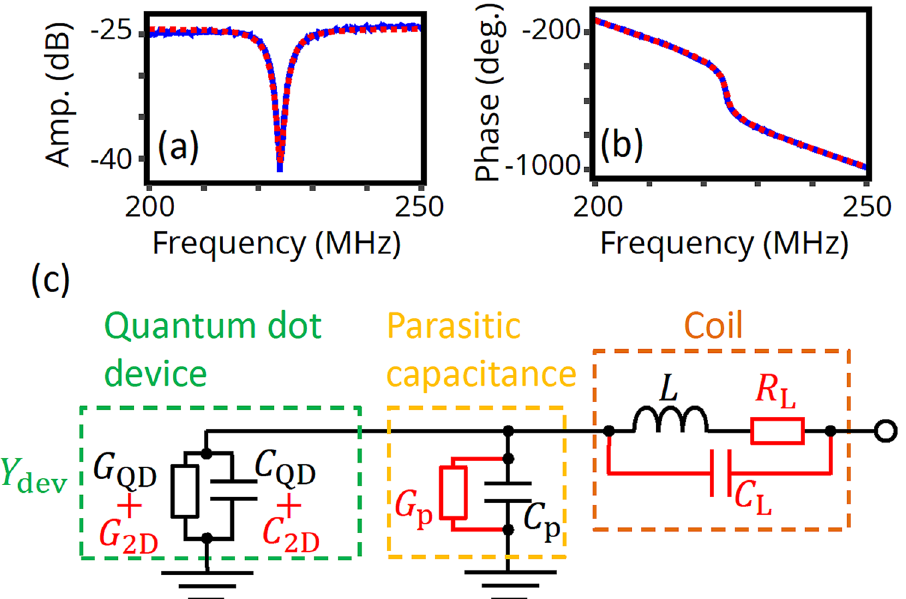
Figure 2. Frequency dependence of reflected RF signal and fitting using an equivalent circuit. ( a , b ) Amplitude and phase of the measured transmission signal from port 1 to port 2 at liquid helium temperature as a function of carrier frequency (blue solid lines). No DC voltages are applied to the device. Results from fitting based on the equivalent circuit in ( c ) are shown as well (red dotted lines). ( c ) An equivalent circuit for the load impedance, in which additional parasitic components are also taken into